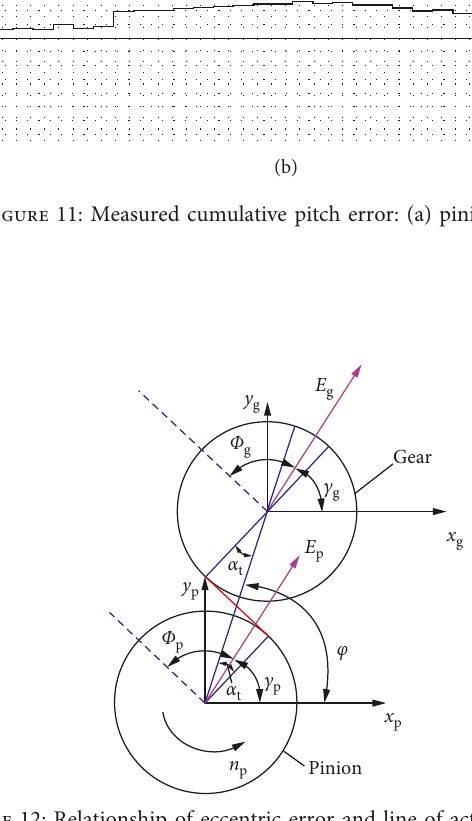
Figure 12: Relationship of eccentric error and line of action on end